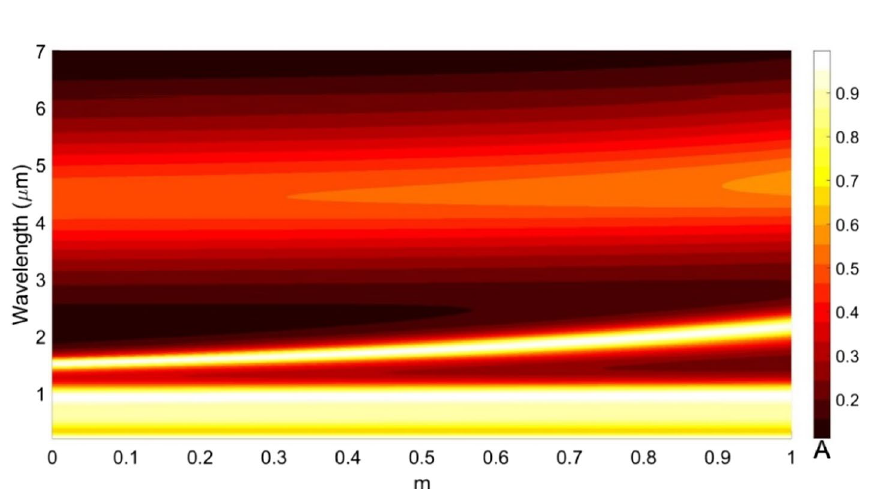
Figure 14. Absorption spectra for different crystalline-to-amorphous ratios of the lower GST layer, while the other parametric and operational conditions are as used in Fig.